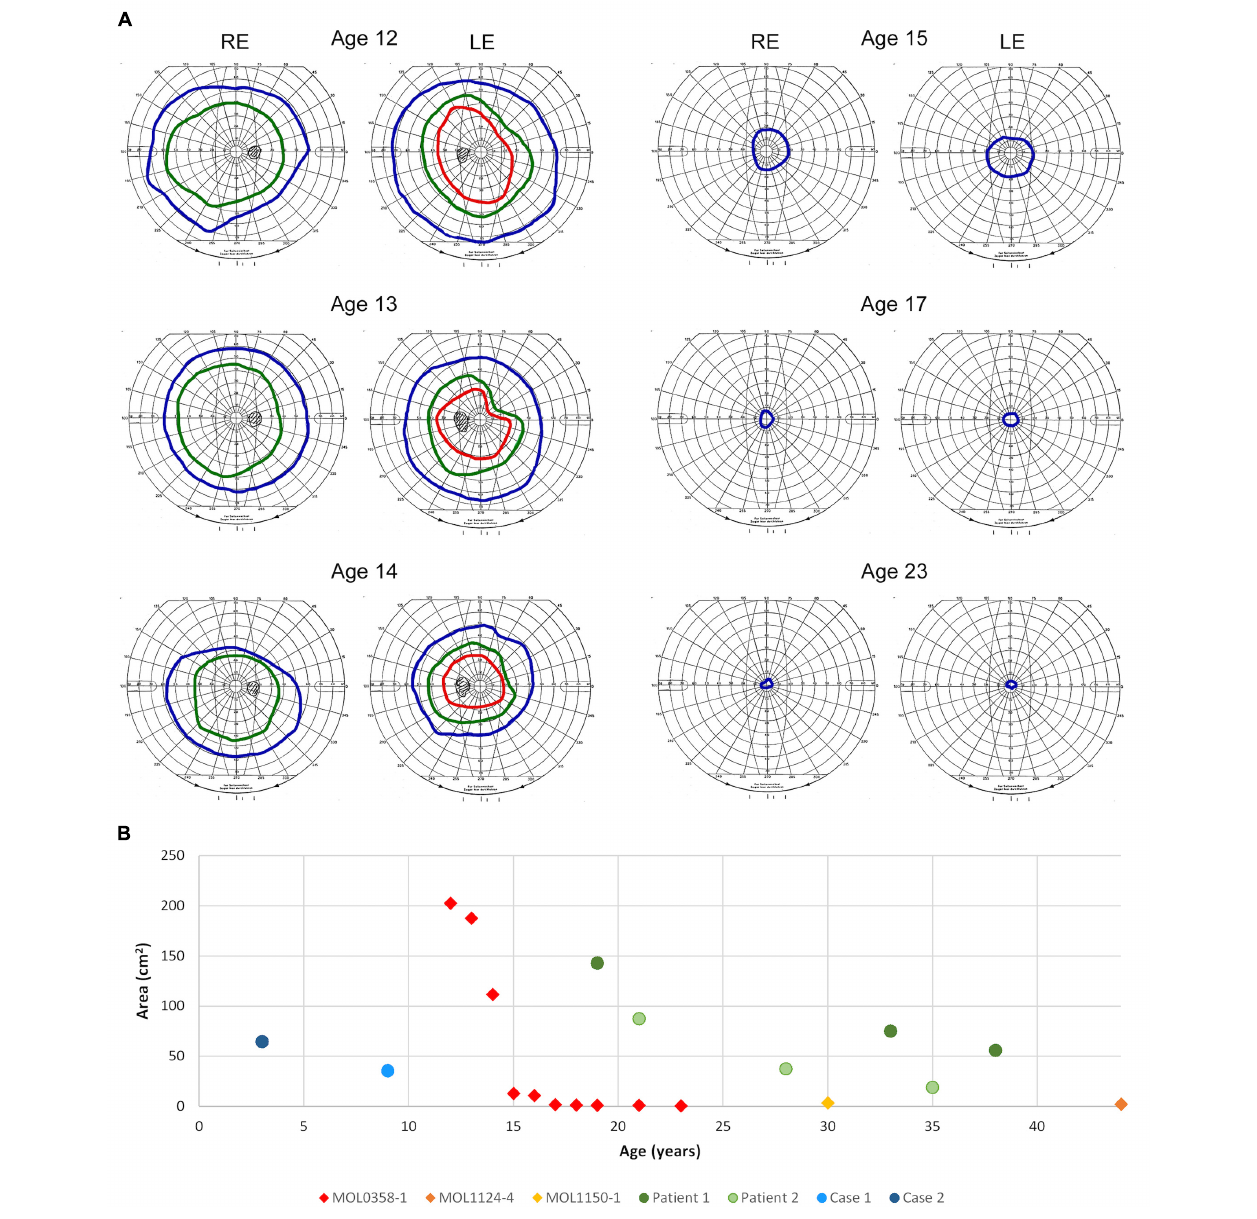
FIGURE 5 | Goldmann kinetic perimetry. (A) Examples of VF from different ages of patient MOL0358-1. Target I4e shown in red, target III4e in green, and target V4e in blue. Rapid constriction of the VF is evident during teen years. (B) Visual field areas of MOL0358-1, MOL1124-4, MOL1150-1, and other patients from the literature (using target V4e) plotted versus age. Average VF of MOL0358-1 are presented in red rhombus. Average VF areas of other patients previously published in the literature are represented by circles: Green circles represent the VF of patients from the article by Sato et al. (2020), and blue circles represent the VF from Suzuki et al. (2014).